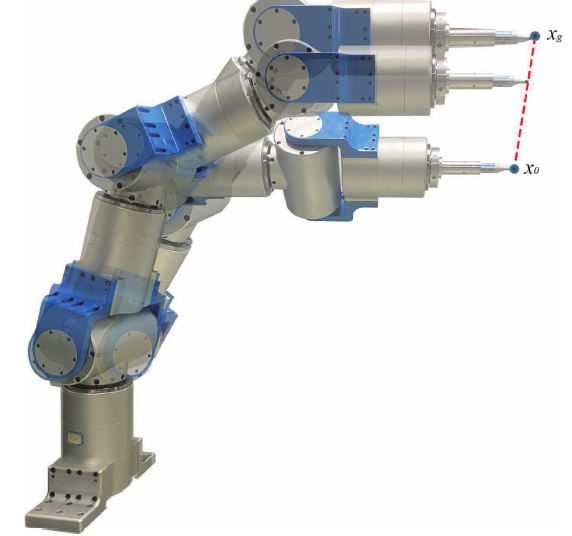
Figure 7. Obstacle avoidance behavior with different values of λ